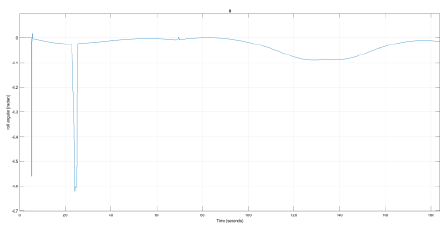
Figure 21. Y distance response for the QAV